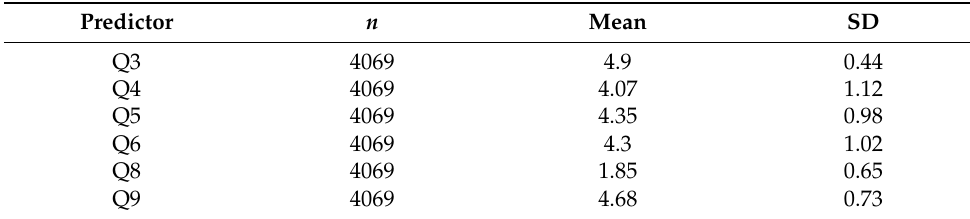
Table 5. Average responses to clinical opinion